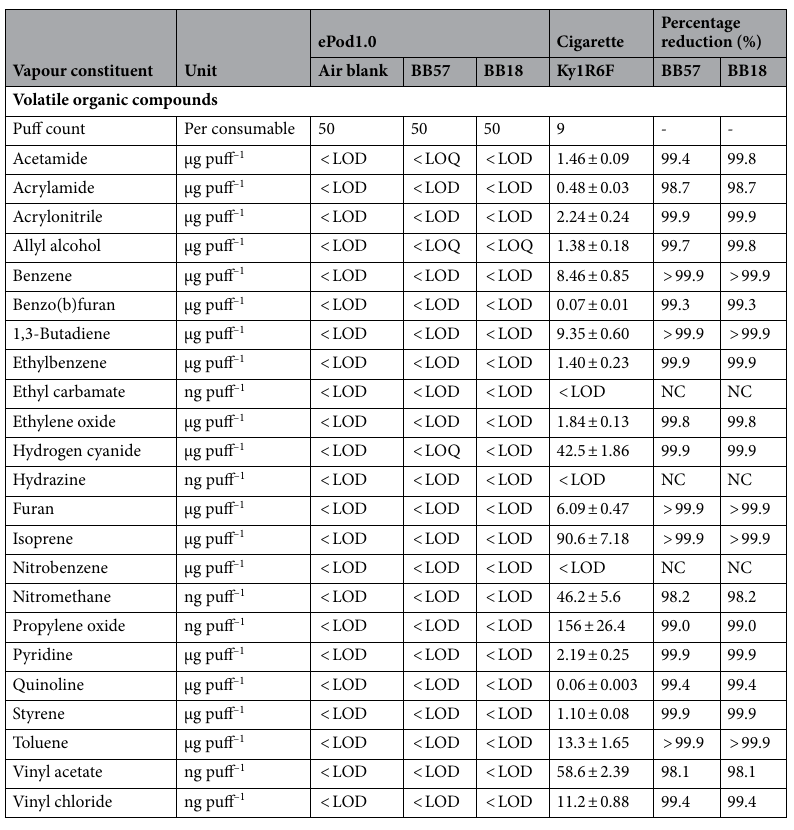
Table 4. Volatiles compounds: Per-puff concentration of e-cigarette vapour emissions, respective method air blanks and Ky1R6F cigarette smoke. Values are presented as mean ± standard deviation (n = 5). Percentage reduction of e-cigarette emissions relative to Ky1R6F cigarette smoke. NC not calculated, LOD limit of detection, LOQ limit of quantification. More information about the analytical methods and respective LODs and LOQs are under the Supplementary Information (Tables S1 and